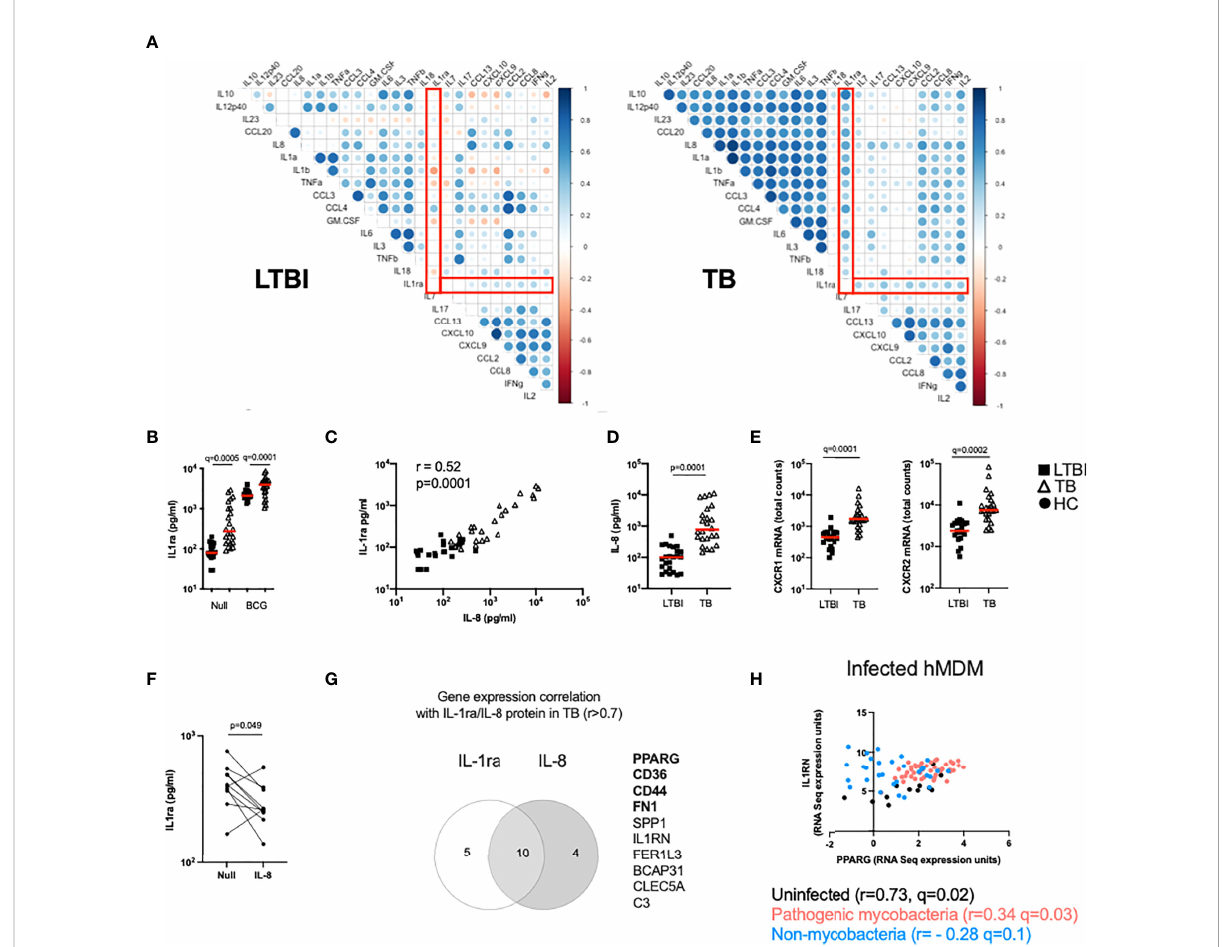
FIGURE 2 The IL-1 pathway is dysregulated in active TB disease. (A) Spearman correlation plot of the induced (Fold-change>1.3 in the BCG condition respect to the Null) proteins measured by Luminex in TruCulture supernatants after BCG stimulation for LTBI and TB. Red rectangles highlight IL-1ra correlations. (B) Levels of IL-1ra protein measured by Luminex in the Null and BCG conditions for LTBI and TB. (C) Spearman correlation between IL-8 and IL-1ra protein levels measured by Luminex in the Null condition. (D) IL-8 concentration measured by Luminex in the Null condition, for LTBI and TB. (E) Gene expression levels of the IL-8 receptor subunits CXCR1 and CXCR2 measured by Nanostring at baseline. (F) IL-1ra protein concentration measured by ELISA in supernatants of whole blood from healthy individuals stimulated with IL-8 (n=10, 4 independent experiments). (G) Venn diagram of the genes correlated with IL-1ra and IL-8 in the Null condition in TB, measured by Nanostring and Luminex, respectively. Genes associated with the PPAR g pathway are in bold. (H) Reanalysis of RNAseq data by Spearman correlation between PPARG and IL1RN gene expression levels of human monocyte-derived macrophages infected with mycobacterial ( M.tb H37Rv, heat- inactivated M.tb H37Rv, M.tb GC1237 and BCG) and non-mycobacterial ( Yersinia pseudotuberculosis , Salmonella typhimurium and Staphylococcus epidermidis ) species for 18 and 48h (19). Comparisons between groups were performed using unpaired or paired (F) non- parametric t-tests and correction for multiple comparisons was applied. Red line: median values. Closed square: LTBI, Open triangle: TB, Closed circle: Healthy Control (HC). For panels (B, E) , q values (false discovery rate-adjusted p values) are